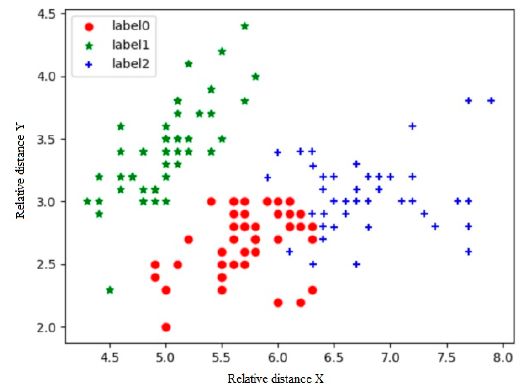
Figure 10. Two-dimensional clustering results obtained by DPCTF algorithm.